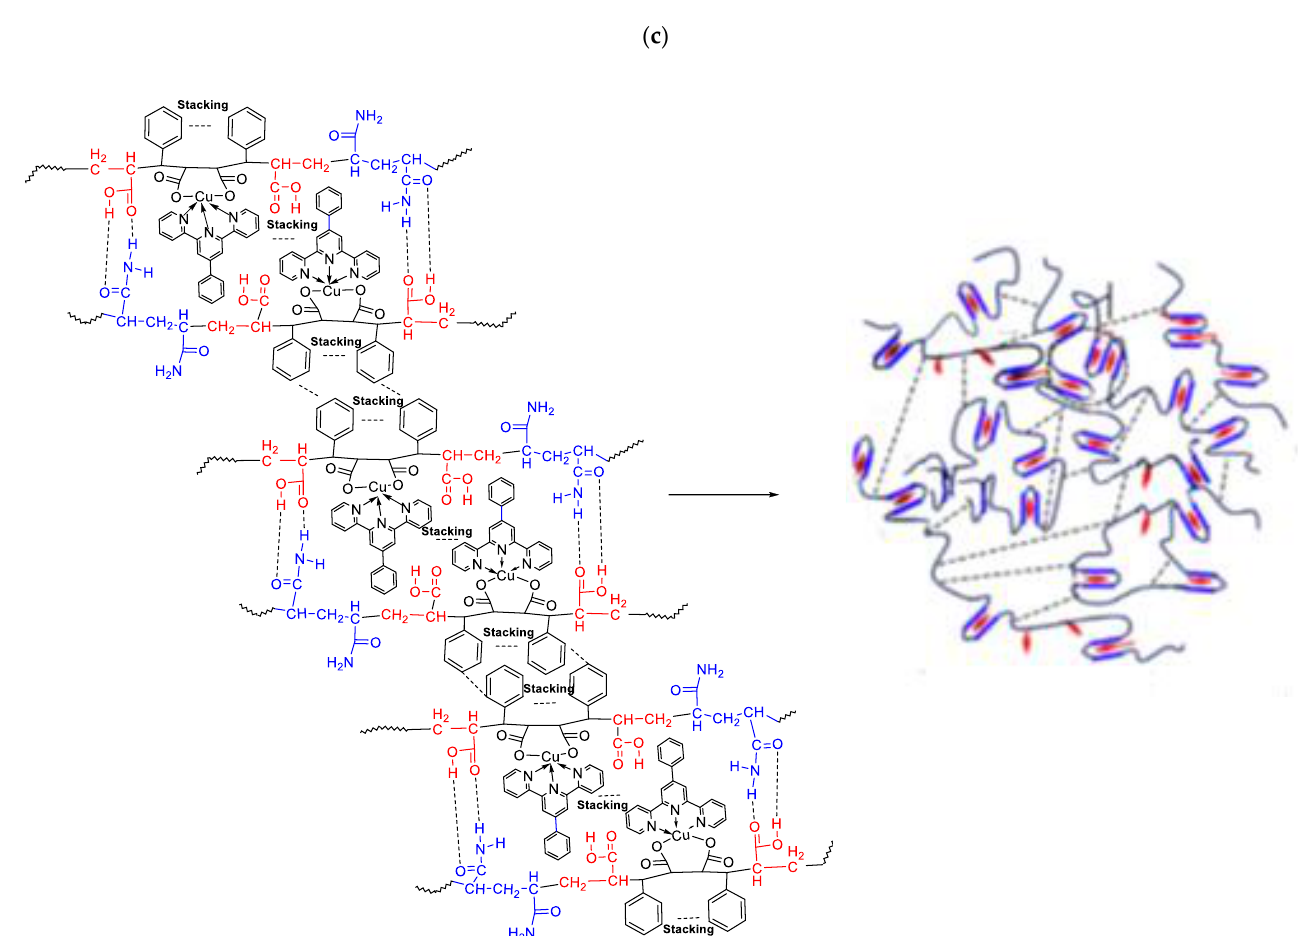
Figure 18. ( a ) IR spectra of copolymers isolated from gel solutions by precipitation in acetone and dried in air: 1 – [AM/AA/CuCinnamatePhTpy = 14.5/84.5/1]; 2 – [AM/AA = 50/50] 50% sol.; 3 – [AM/AA/ZnAcrylatePhTpy = 49.5/49.5/1] 50% sol.; 4 – [AM/AA/ CuCinnamatePhTpy = 84.5/14.5/1]; 5 – [AM/AA/CuCinnamatePhTpy = 49.5/49.5/1] 50% sol.; 6 – [AM/AA/CuCinnamatePhTpy = 49.5/49.5/1]; 7 – [AM/AA/ZnAcrylatePhTpy = 84.5/14.5/1]; 8 – [AM/AA/CuCinnamatePhTpy = 84.5/14.25/1.25]; ( b ) a scheme of a radical polymerization of AA, AM, CuAcrylatePhTpy; ( c ) sche- matic representation of the structure of the obtained copolymer P(AM-co-AA-co- MCMPhTpy). Data of [180].